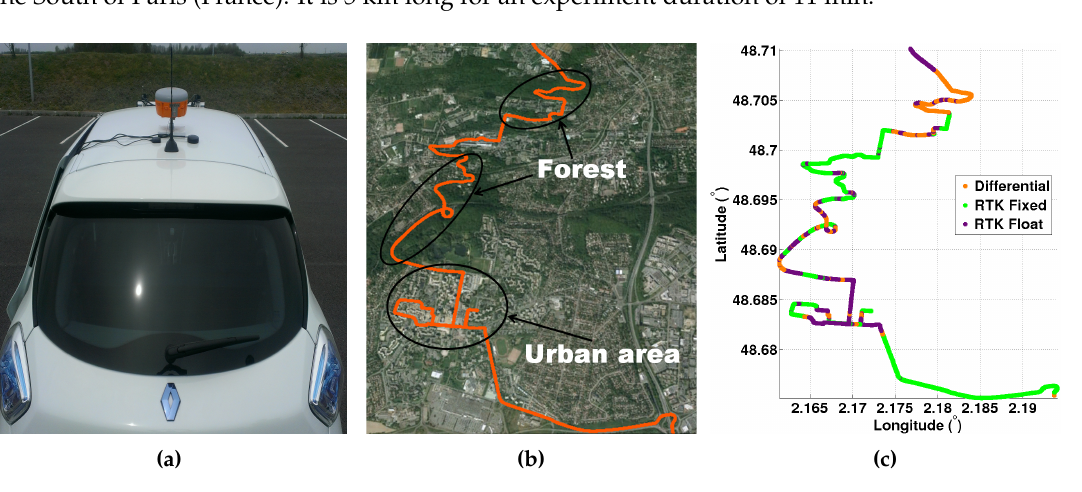
Figure 1. ( a ) Experimental platform with the three GPS visible on the roof of the car; ( b , c ) trajectory of the experiment, either ( b ) plotted on Google Earth c (cid:13) or ( c ) labeled in terms of the quality of the Real-Time Kinematic (RTK) solution (“ground